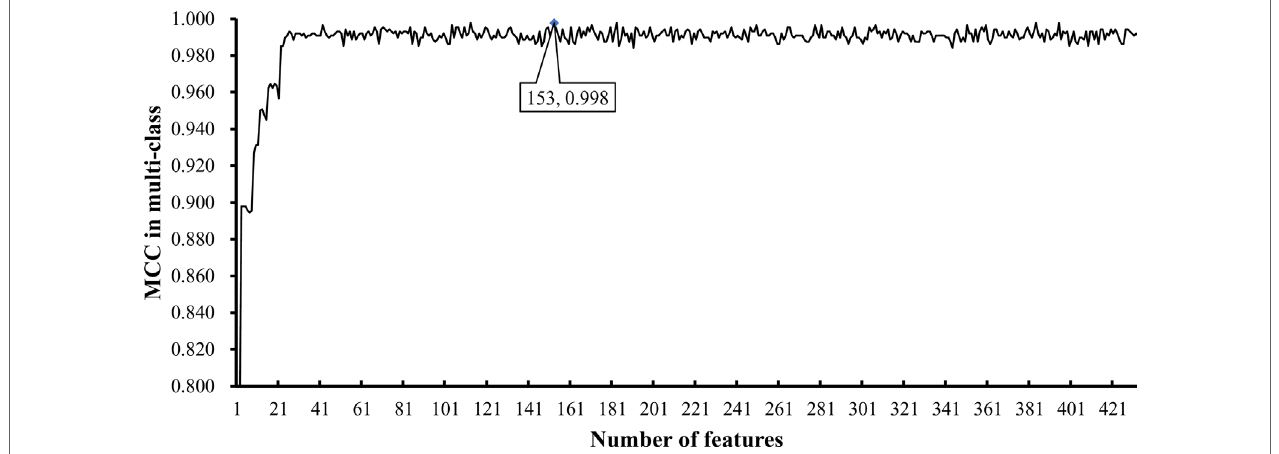
FIgURe 2 | Optimal performance of IFS with RIPPER algorithm. The RIPPER algorithm provided the highest MCC (0.998) when top 153 features were